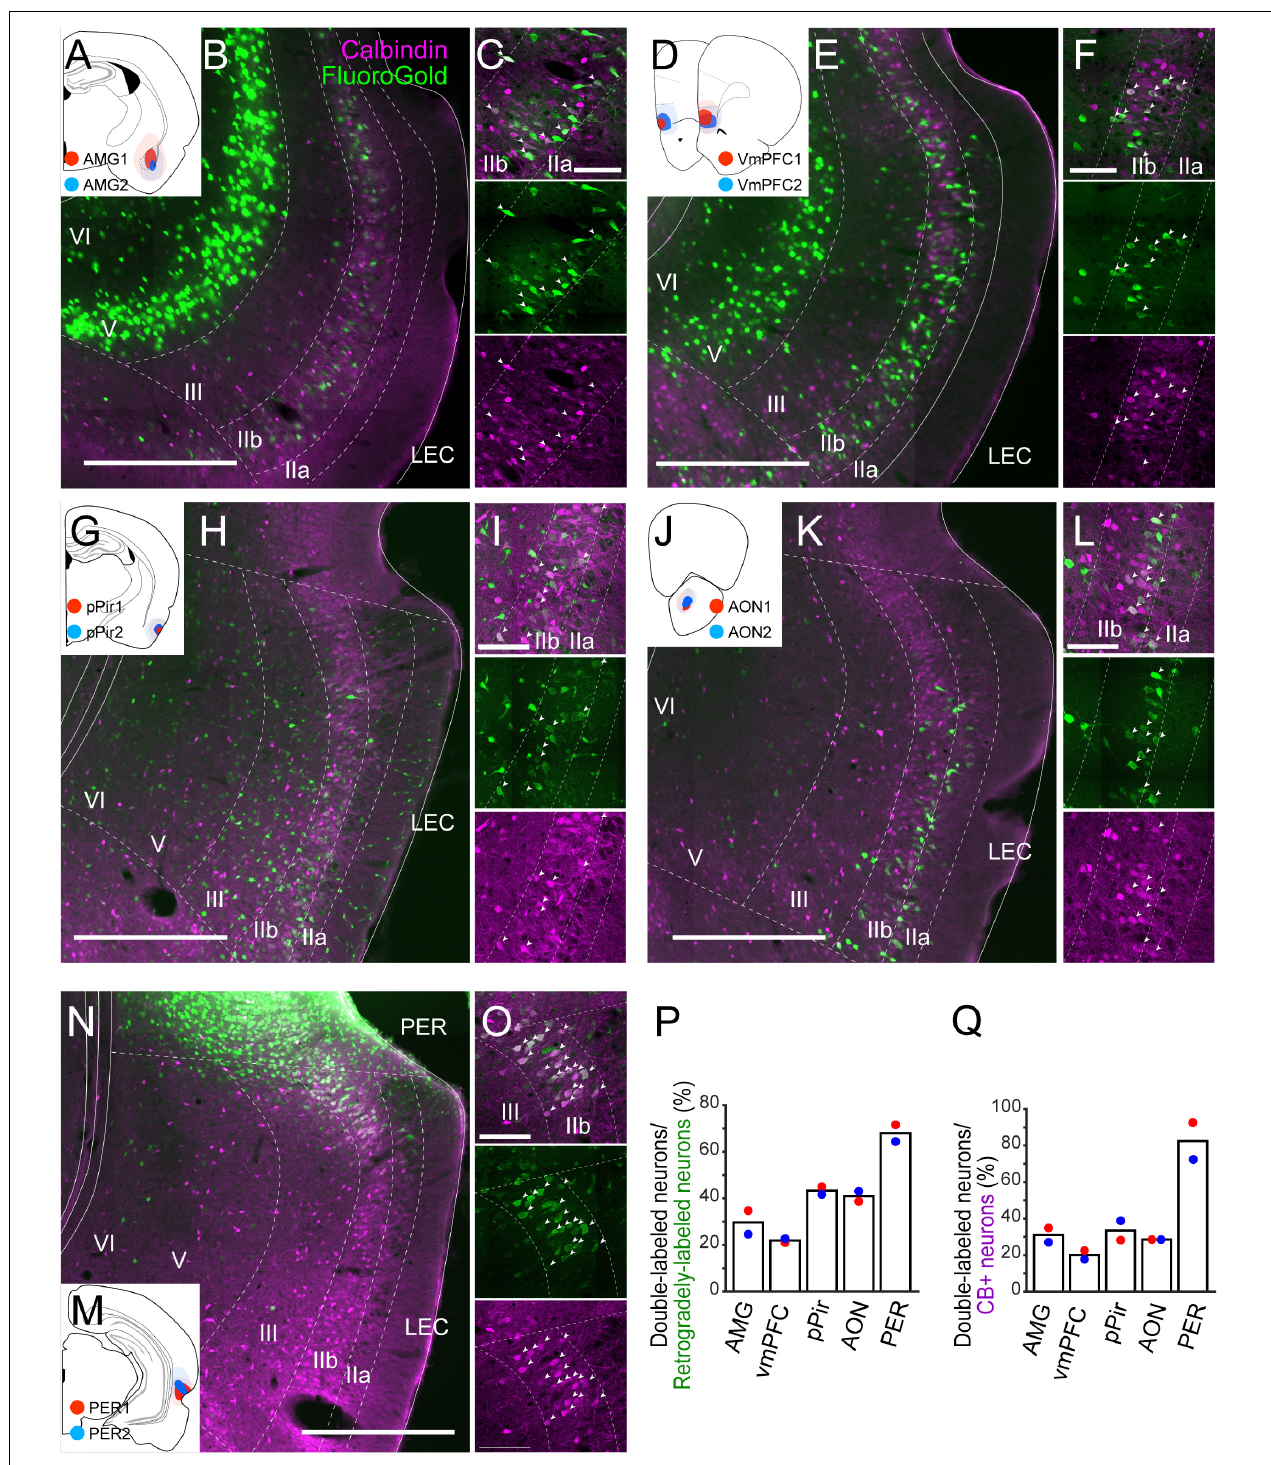
FIGURE 3 | Projections of LEC CB+ neurons to telencephalic structures. FG was injected either in AMG (A) , vmPFC (D) , pPir (G) , AON (J) , or PER (M) . Each injection is illustrated with a different color. For each injection, the dark color shows the injection site while the light color shows the area of diffusion. Distribution of retrogradely labeled neurons in LEC after FG injection in AMG ( B,C , case: AMG1), vmPFC ( E,F , case: vmPFC2), pPir ( H,I , case: pPir2), AON ( K,L , case: AON2), and PER ( N,O , case: PER2) in coronal sections. White arrows indicate neurons that were double-labeled with FG and CB immunoreactivity. (P,Q) The percentage of double-labeled neurons among retrogradely-labeled neurons ( N = 2 each, P ), and the percentage of double-labeled neurons among the CB+ neurons ( N = 2 each, Q ) in LEC. Scale bars are 500 µ m for panels (B,E,H,K,N) , and 100 µ m for panels (C,F,I,L,O) .